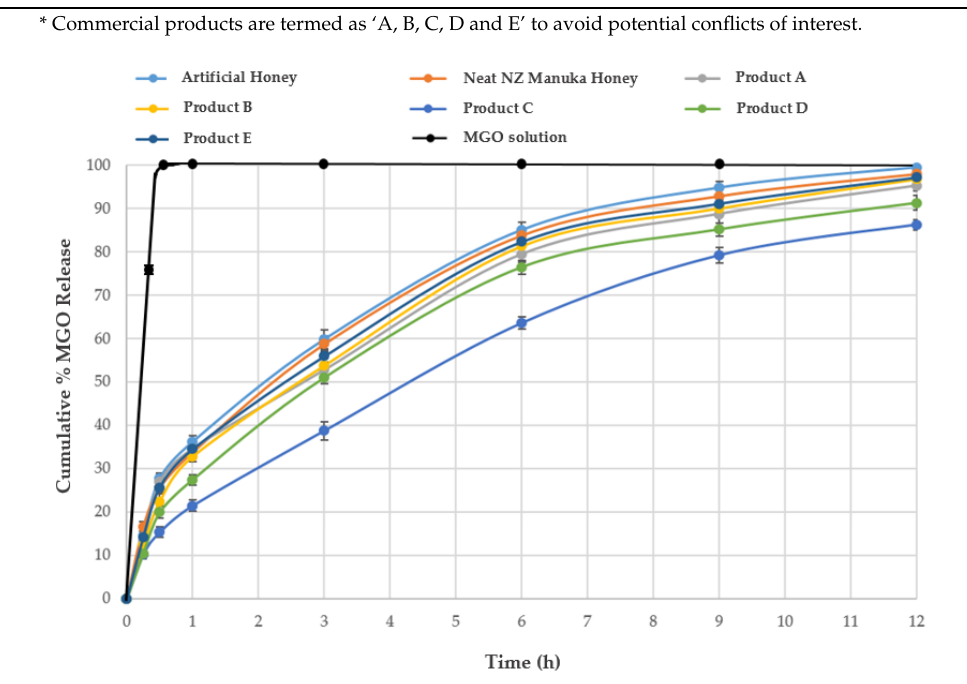
Figure 6. Cumulative % MGO release from pure MGO solution, five commercial products, spiked artificial honey and pure NZ Manuka honey at different time points. Table 2. MGO Release rate ( n = 3, data represents mean ±